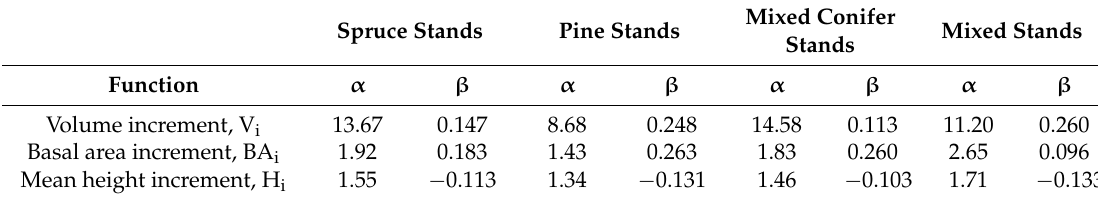
predicted increment. SD “ α ` β